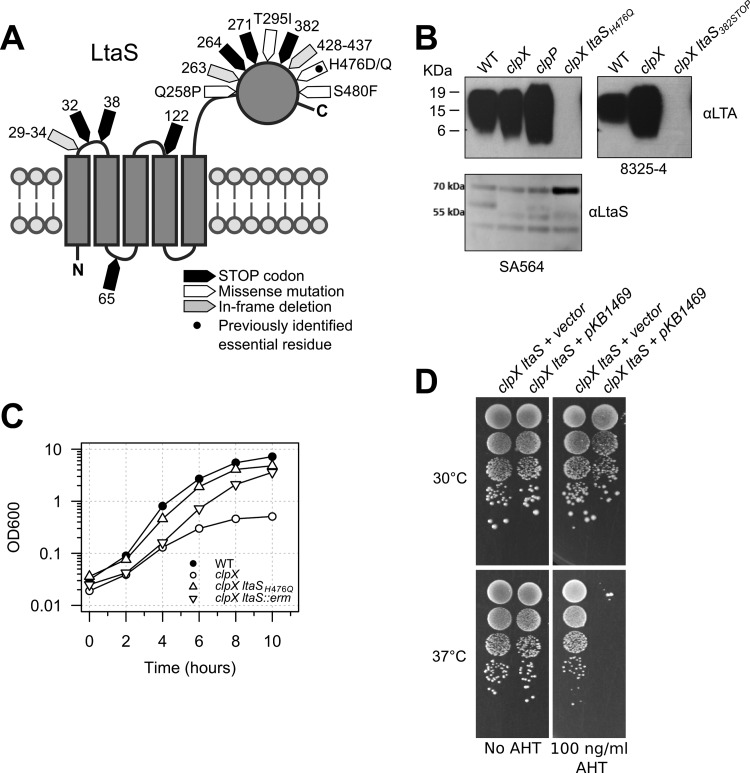
Mutations in the ltaS gene restore growth of the S. aureus clpX mutant. (A) Topology map of LtaS showing the location and class of the identified suppressor mutations. (B) Analysis of LTA synthesis. Extracts obtained from S. aureus strains SA564 (wild type), SA564 clpX, SA564 clpP, 564-25-2 (SA564 clpX ltaSH476Q), 8325-4 (wild type), 8325-4 clpX, and 83-25C (clpX ltaS382STOP) grown at 30°C and normalized based on optical density (OD600) readings of the original cultures were separated by SDS/PAGE, electrotransferred to a polyvinylidene difluoride (PVDF) membrane, and subjected to immunoblotting using an LTA-specific or an LtaS-specific antibody as indicated. (C) Growth of the S. aureus SA564 wild-type strain, the SA564 clpX strain, the 564-25-2 (SA564 clpX ltaSH476Q) spontaneous suppressor strain, and the SA564 clpX ltaS::erm strain at 30°C in TSB. (D) LtaS is essential at 37°C but not at 30°C. The 8325-4 clpX ltaS382STOP suppressor mutant harboring either a plasmid expressing ClpX under the control of an AHT-inducible promoter or empty vector was grown in TSB at 37°C and diluted 101-, 102-, 103-, and 104-fold. Ten microliters of each dilution was spotted on TSA plates supplemented with AHT as indicated and subsequently incubated at either 30°C or 37°C.